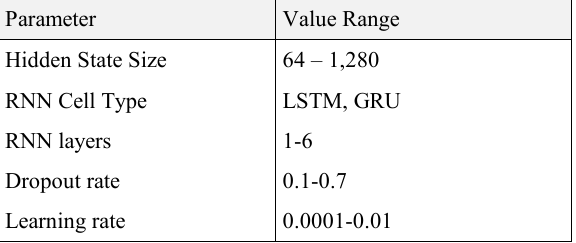
Table 4. L1 test loss for the pollutants